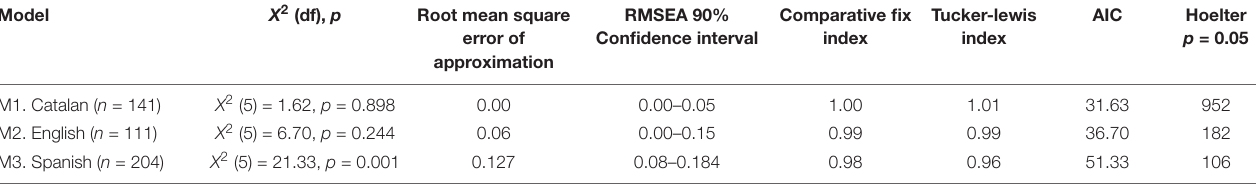
RMSEA 90% Comparative fix error of Confidence interval index approximation